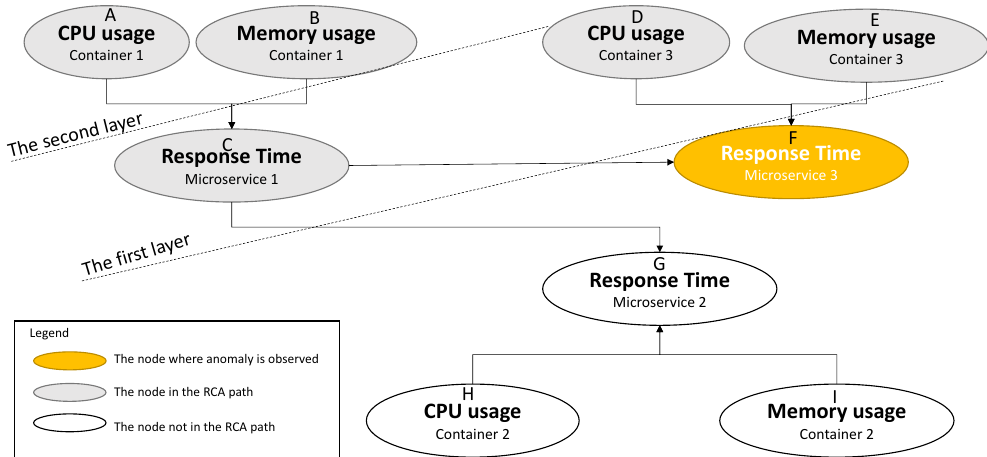
Figure 6. A root cause tracing example for performance anomaly.